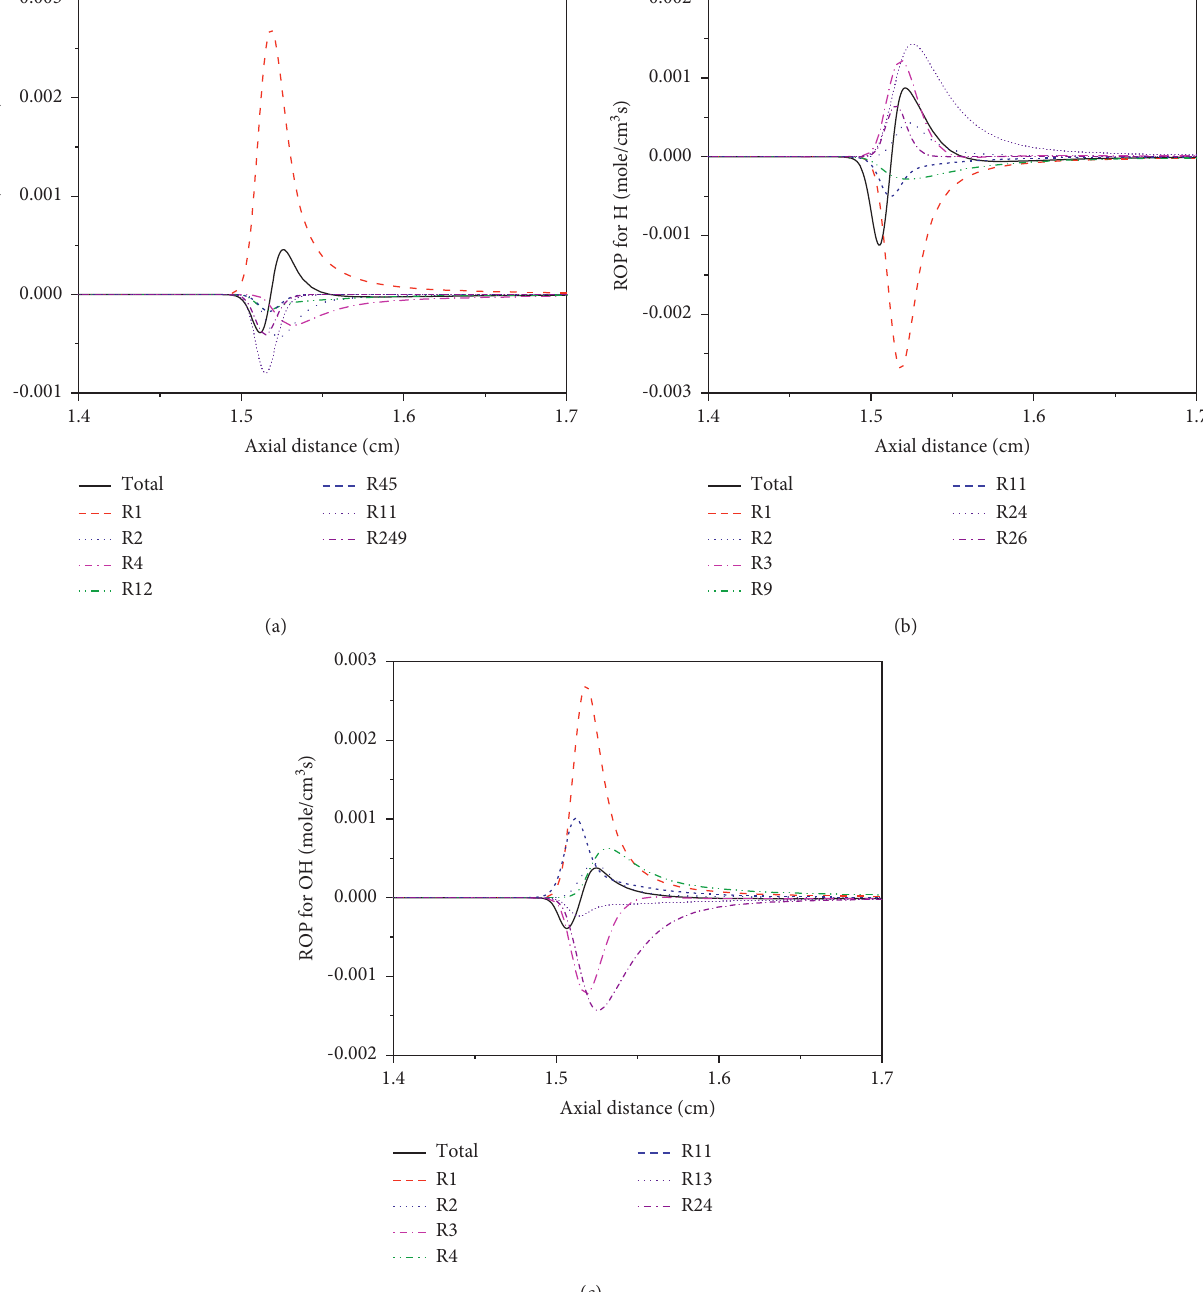
Figure 11: Axial distributions of ROP for O, H, and OH radicals through the key reactions in laminar flame of different reforming species and